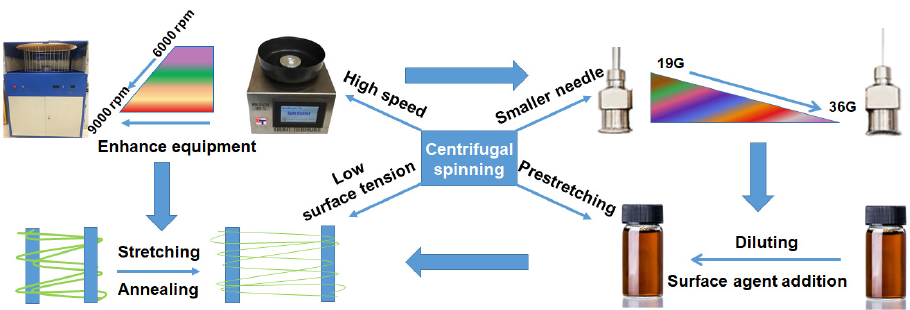
Figure 7. Schematic illustration of a method to reduce the diameter of centrifugal-spun fiber.